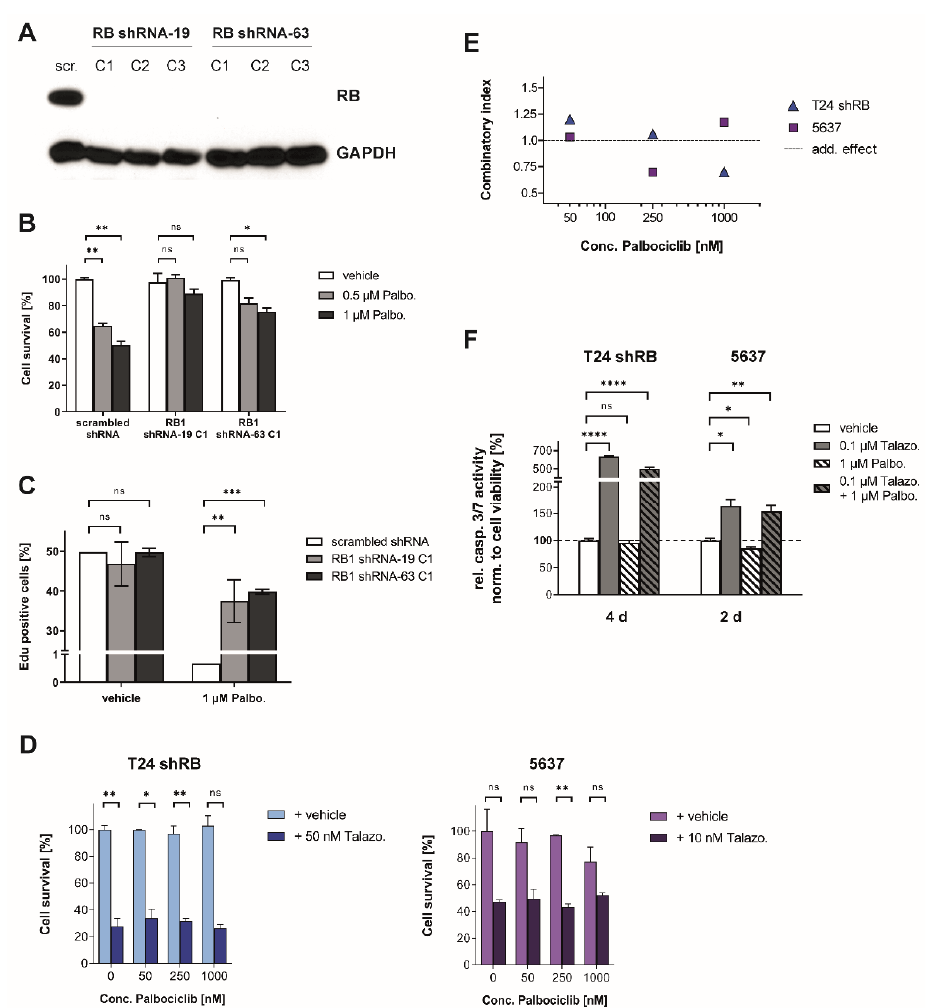
Figure 7. The Knockdown of RB reverses both, the synergism and the retention of apoptosis induction in the Talazoparib/Palbociclib combinatory therapy. ( A ) Western blot analysis of RB expression after lentiviral transduction of the corresponding shRNA. ( B ) Response to treatment with Palbociclib; cell viability measured via Cell Titer-Blue assay 72 h after treatment. ( C ) Flow cy- tometric analysis after EdU incorporation and 7-AAD staining, 24 h after treatment. ( D ) Cell via- bility was analyzed via Sulforhodamin B assay 5 days after treatment. ( E ) Quantification of syner- gism using cell viability data. Combinatory indices (CI) were calculated using the Chou–Talalay